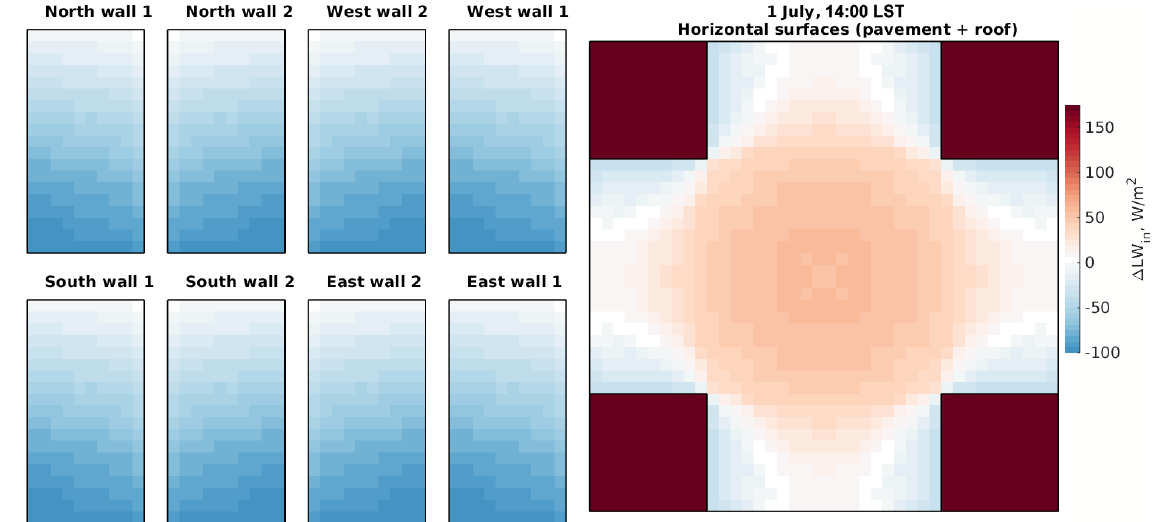
Figure 6. Changes in the received LW radiation flux within the focus domain of the simple urban configuration when considering the surface sky-view factors (RTM_02) compared to the RTM_01. Walls (left plot), pavements (in the centre of the right plot), and roofs (rectangles on all four sides in the right plot) are folded. See the details of the focus domain of the simple urban configuration in Fig.